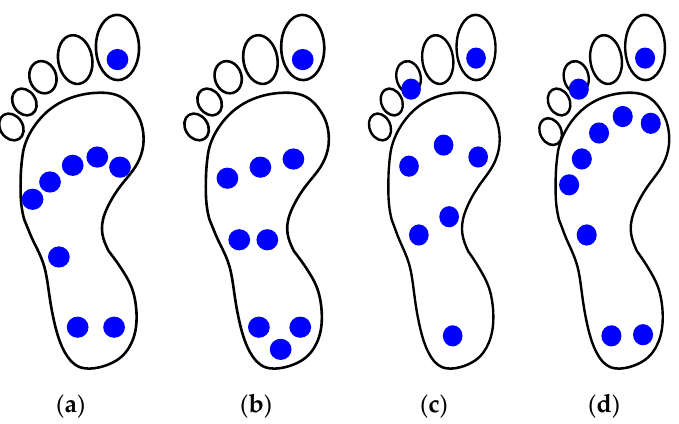
Figure 5. Solutions of pressure sensor deployment on the footprint for dynamic assessment: ( a ) assessment of the footprint medial line with sensors deployed onto the hallux, metatarsal arch, lateral arch and heel respectively [13], ( b ) additional sensor deployed on the medial arch for flatfoot identification [14], ( c ) additional sensor deployed on the lesser toes and medial arch for flatfoot identification [15], ( d ) additional sensor deployed on the lesser toes [16]. Table 1. Muscular activity throughout the stance phases of the gait cycle [10].